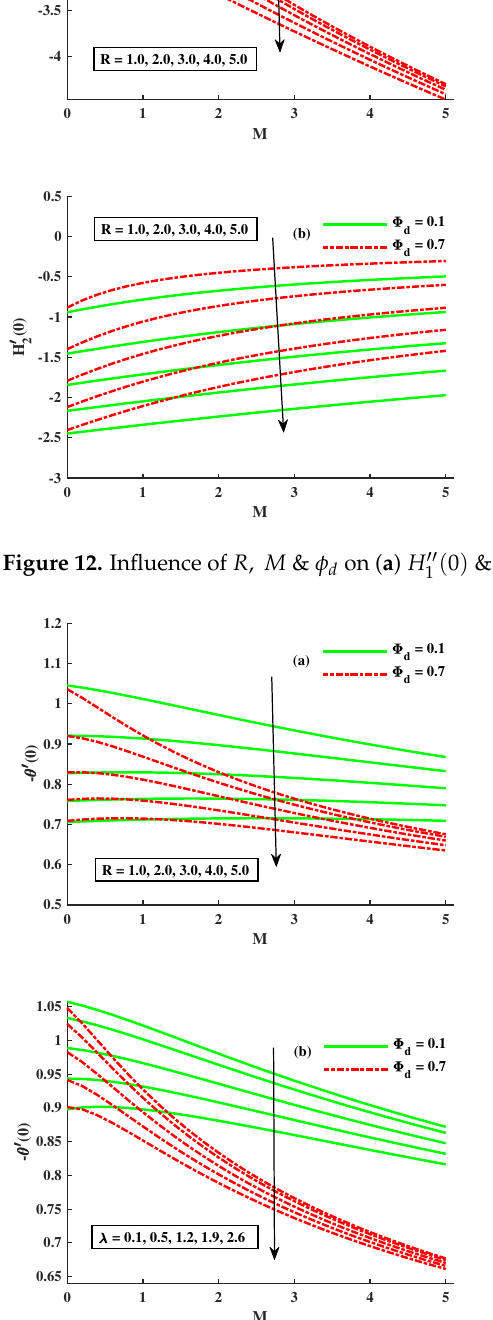
Figure 13. Influence of R, λ and φ d on ( a , b ) − θ (cid:48) ( 0 )